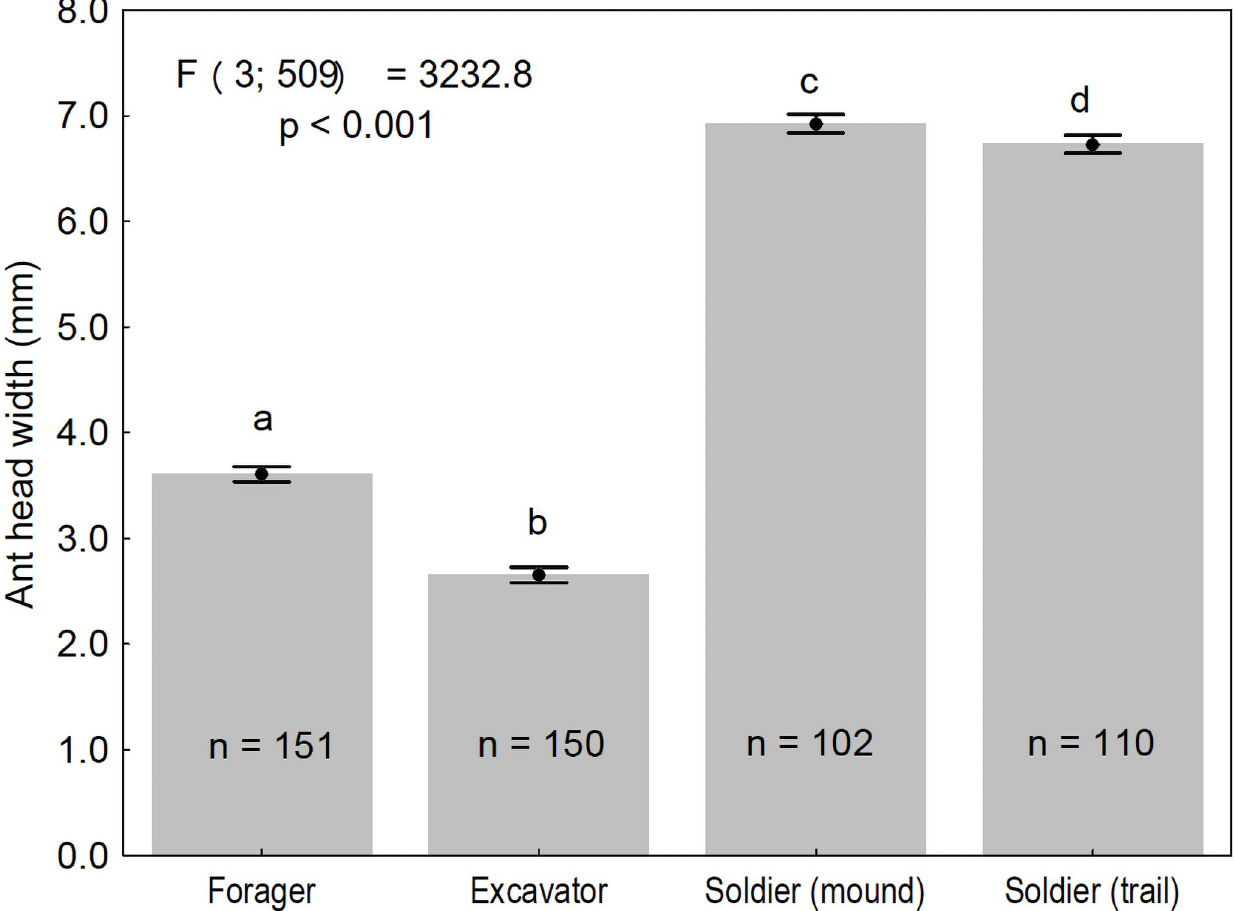
Fig 2. Comparison of head capsule width of non-parasitized Atta laevigata workers collected from mounds (excavators and soldiers) or from trails (foragers and soldiers). Note: Vertical bars indicate 95% confidence intervals, and different letters indicate significant differences between mean head capsule widths (one-way ANOVA and Tukey’s test at 5% level). The original data was transformed using box-cox ( λ =